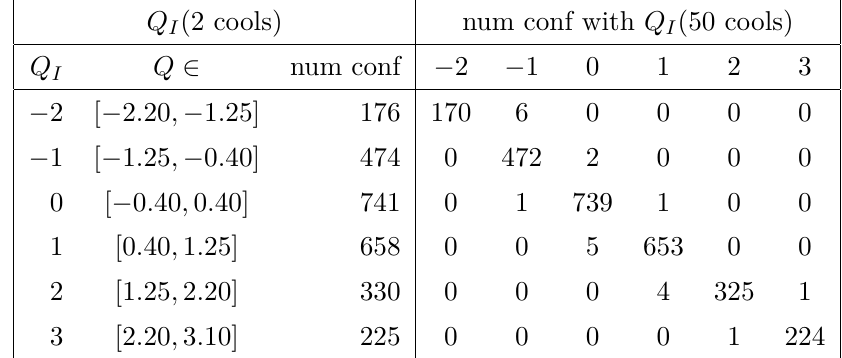
Table 19 . Number fields with topological charge Q I after 50 cooling sweeps of fields with the specified topological charge after 2 cooling sweeps. On a 26 3 38 lattice at β = 6 . 50 . Charges Q I at 2 cools assigned when lattice charge Q lies in the intervals shown.